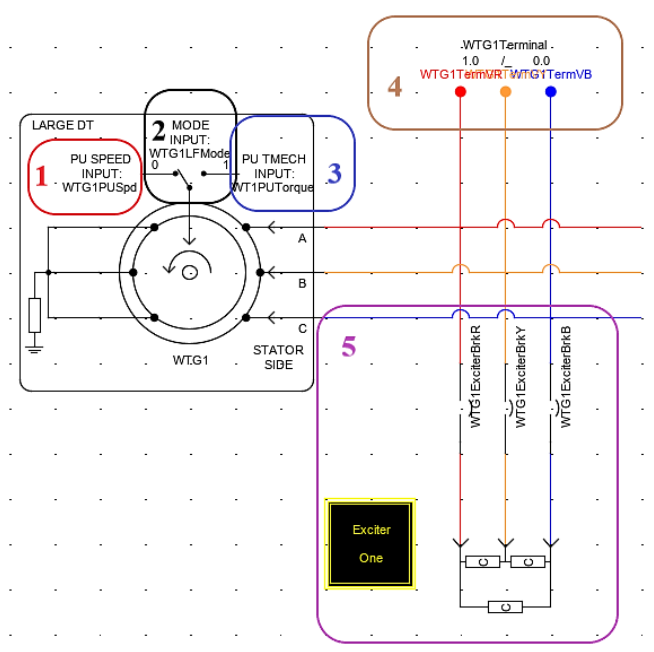
Figure 15. The squirrel - cage induction generator model with the exciter circuit.